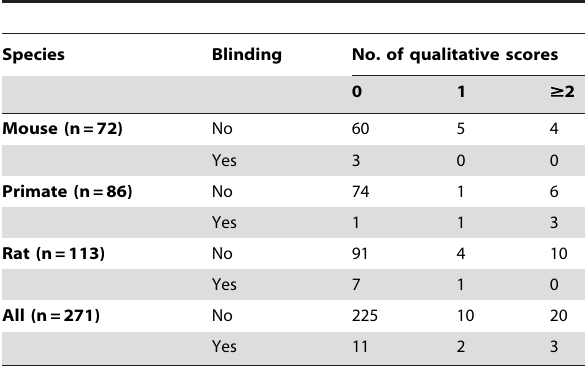
Table 17. Number of papers which used statistical methods reported the method used and also used an error measure.